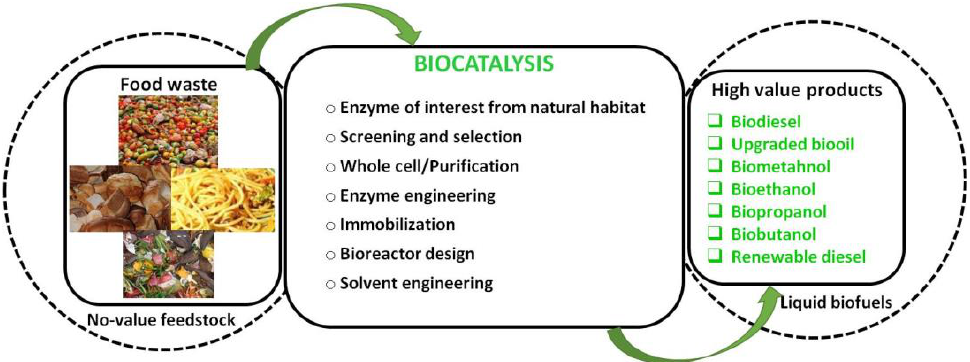
Figure 9. Enzymatic preparation of liquid biofuels from food waste.